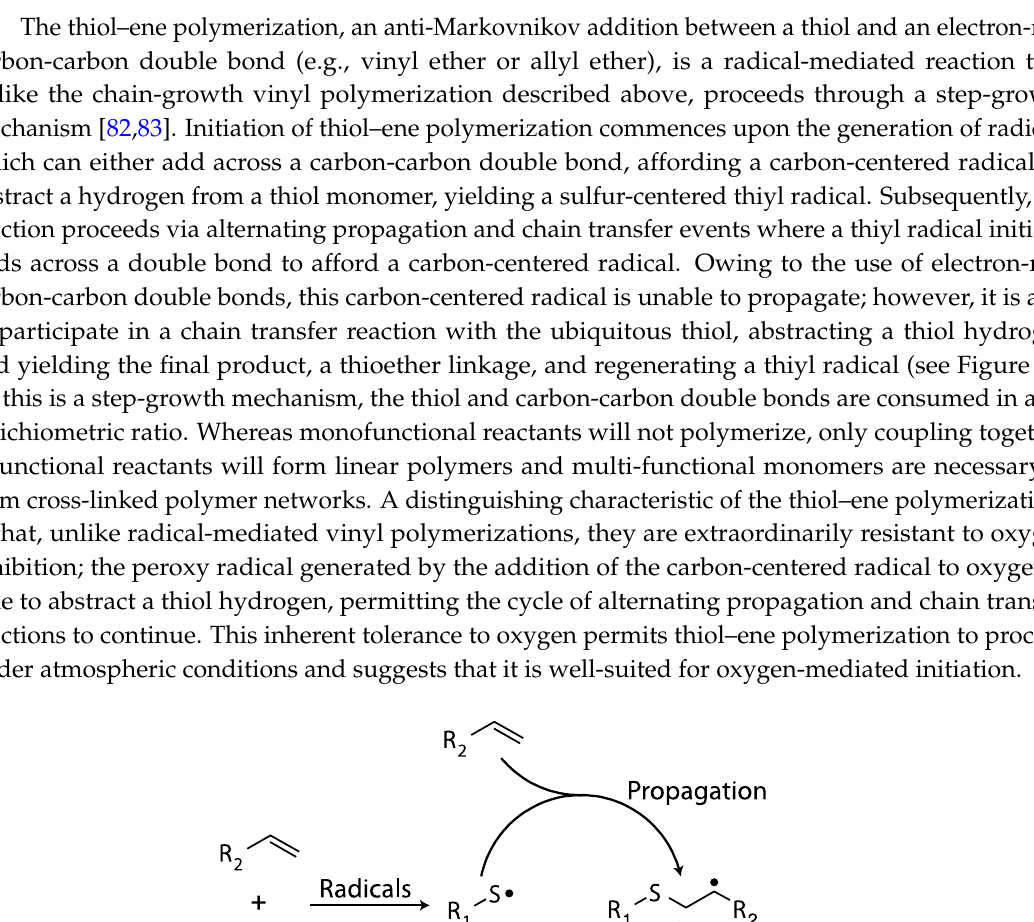
Figure 9. Reaction between a radical on a growing chain and a reversible addition fragmentation chain transfer (RAFT) agent [79]. This is the key process in RAFT polymerization.